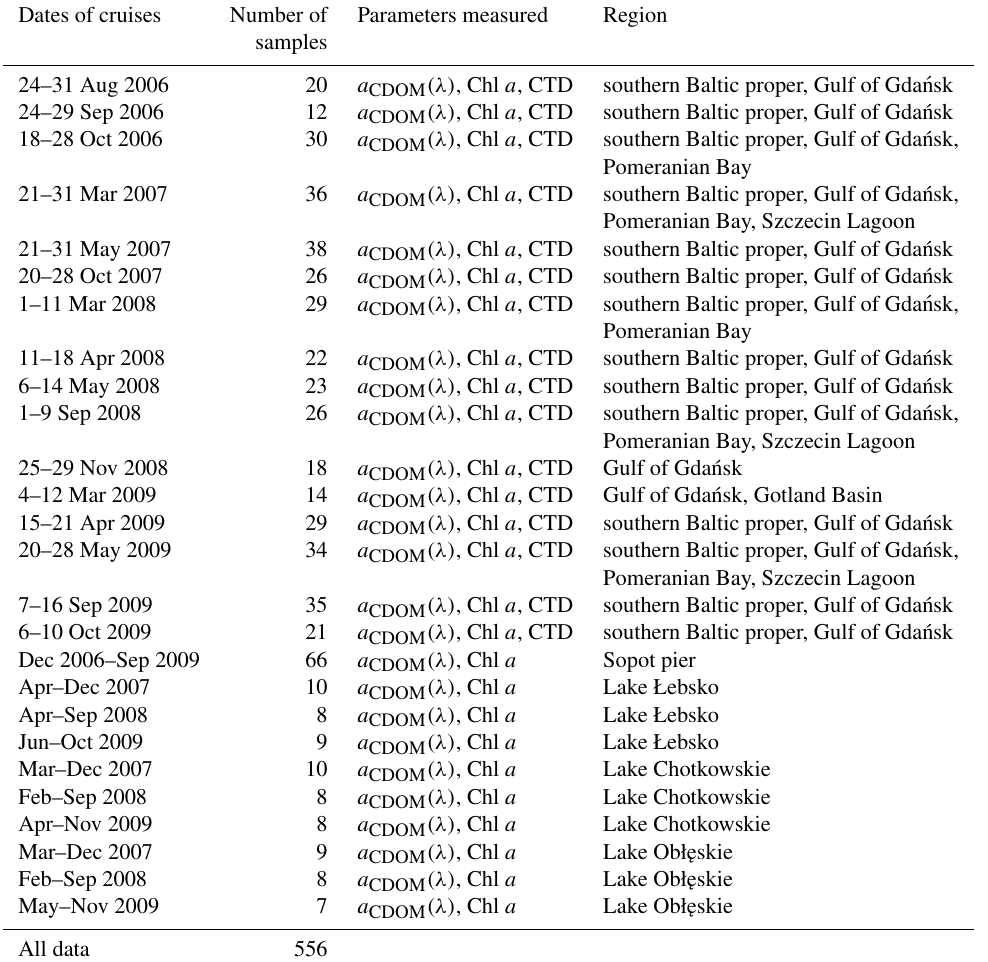
Table 1. Dates, numbers of samples collected and parameters measured during cruises and field experiments carried out for this study. Dates of